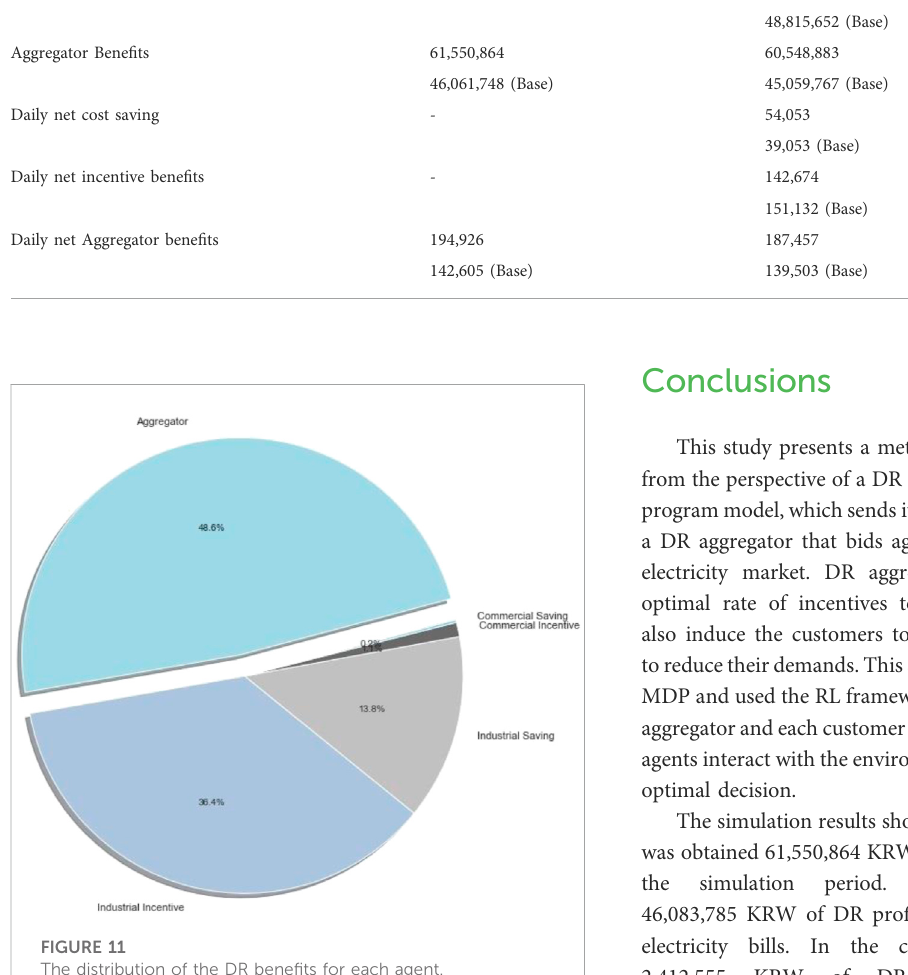
FIGURE 11 The distribution of the DR bene fi ts for each